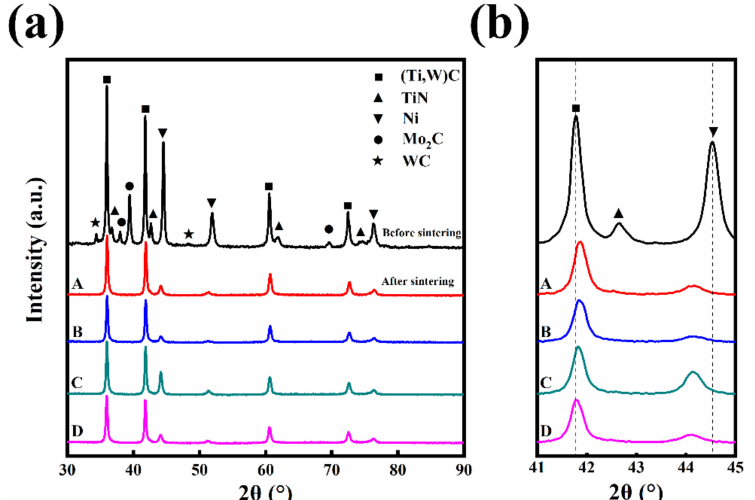
Figure 2. ( a ) XRD patterns of the (Ti,W)C-xTa-based cermets before and after sintering (before sintering: x = 3 wt.%), ( b ) Local magnification of ( a